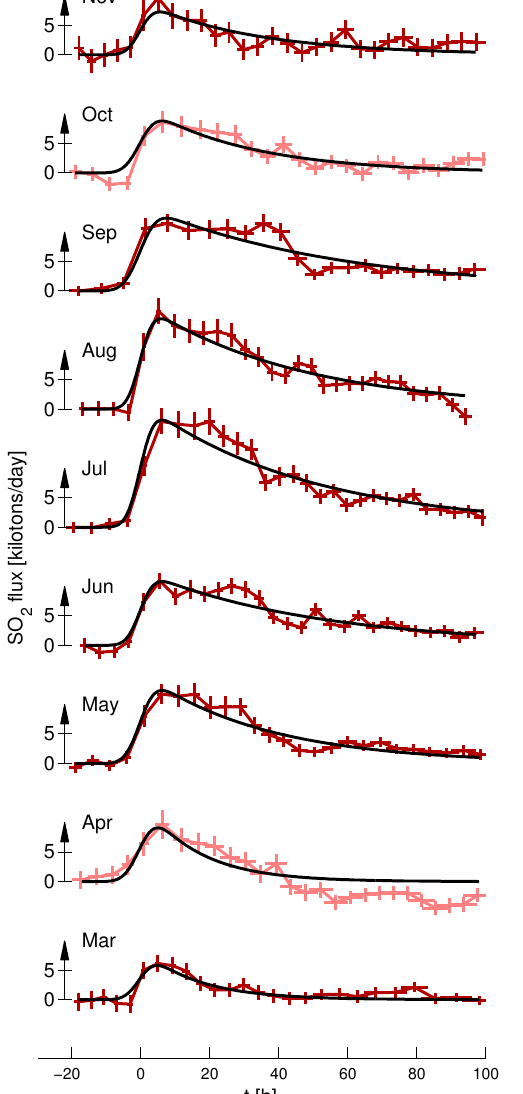
Figure 4. Measured SO 2 flux (i.e., latitudinally integrated VCD times wind speed u ) as function of time for March–November 2008 (red) and the fitted exponential downwind decay according to Eq. (1) (black). Light red (April, October) indicates months in which ECMWF winds turned westerly for at least one 6h time step. Error bars in x and y reflect the statistical error of the mean SO 2 flux and the statistical error of t deduced from ECMWF wind variability,